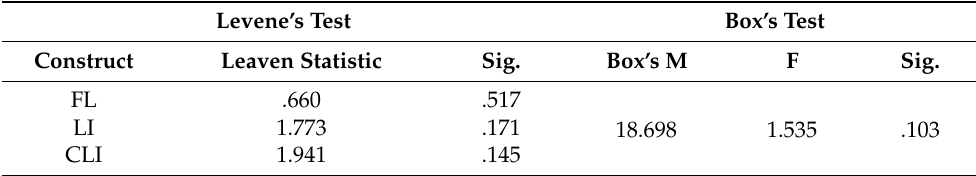
Table 1. Homogeneity and equality of covariance